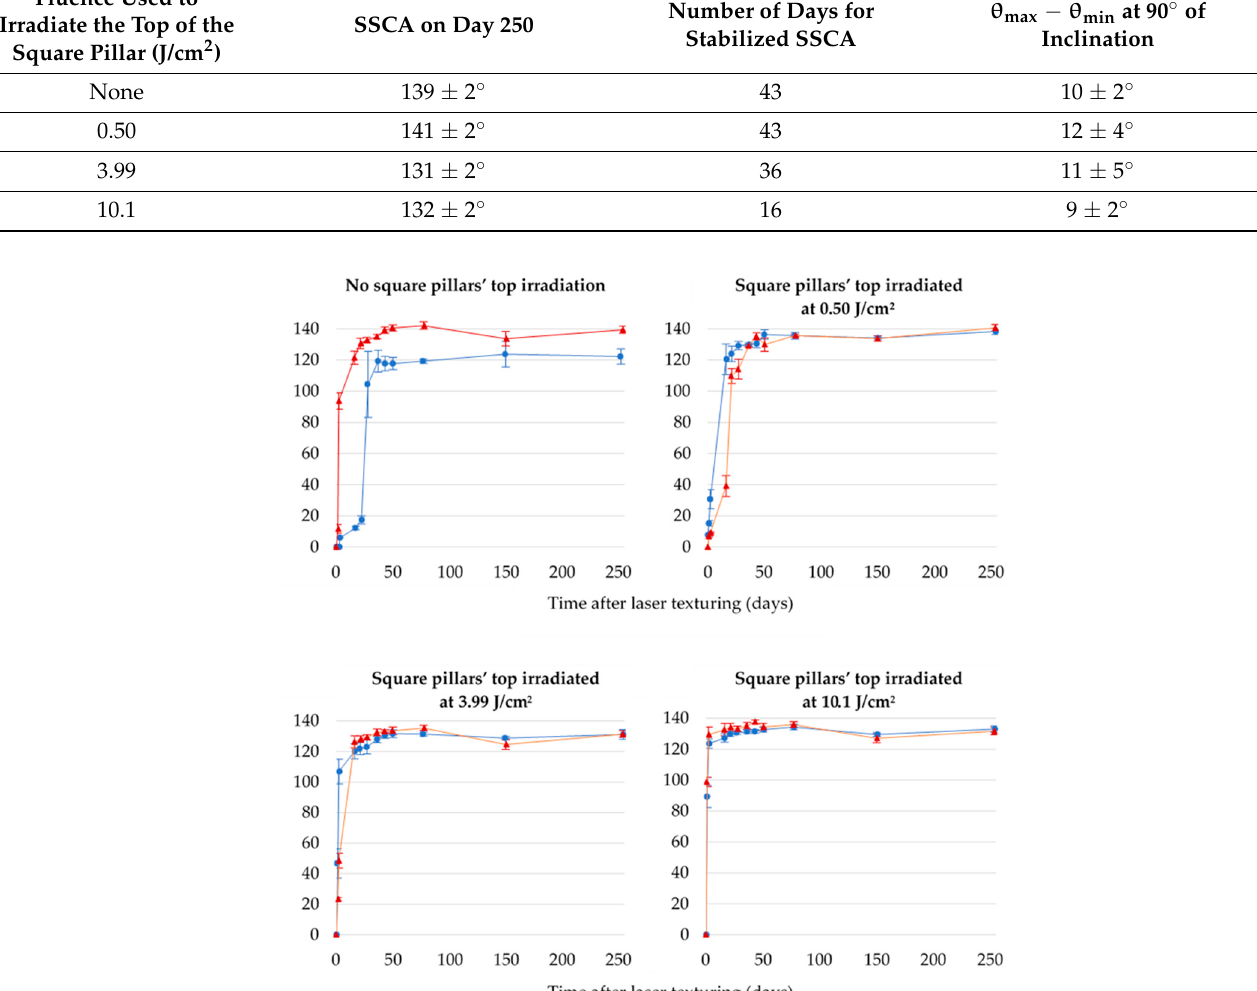
Table 2. Wetting measurement results for the samples textured under a CO 2 flow.